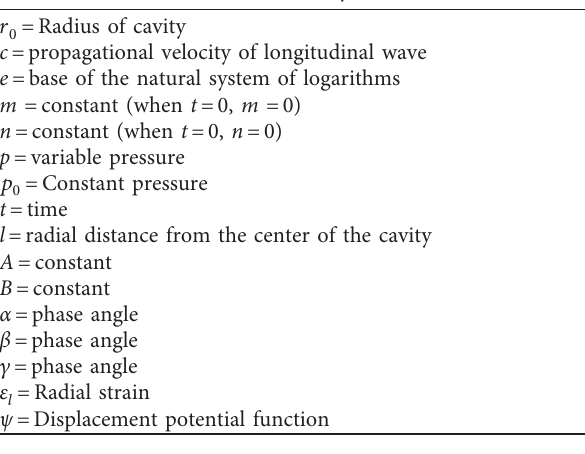
Table 1: List of symbols.